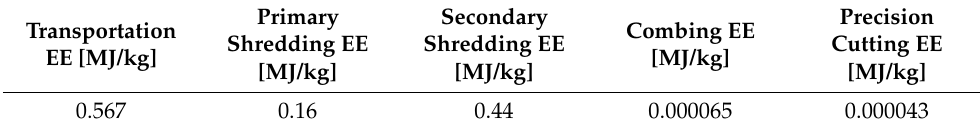
Figure 5. EE of the solvolysis process. Table 3. Break up of EE for transportation, size reduction, and post processing.